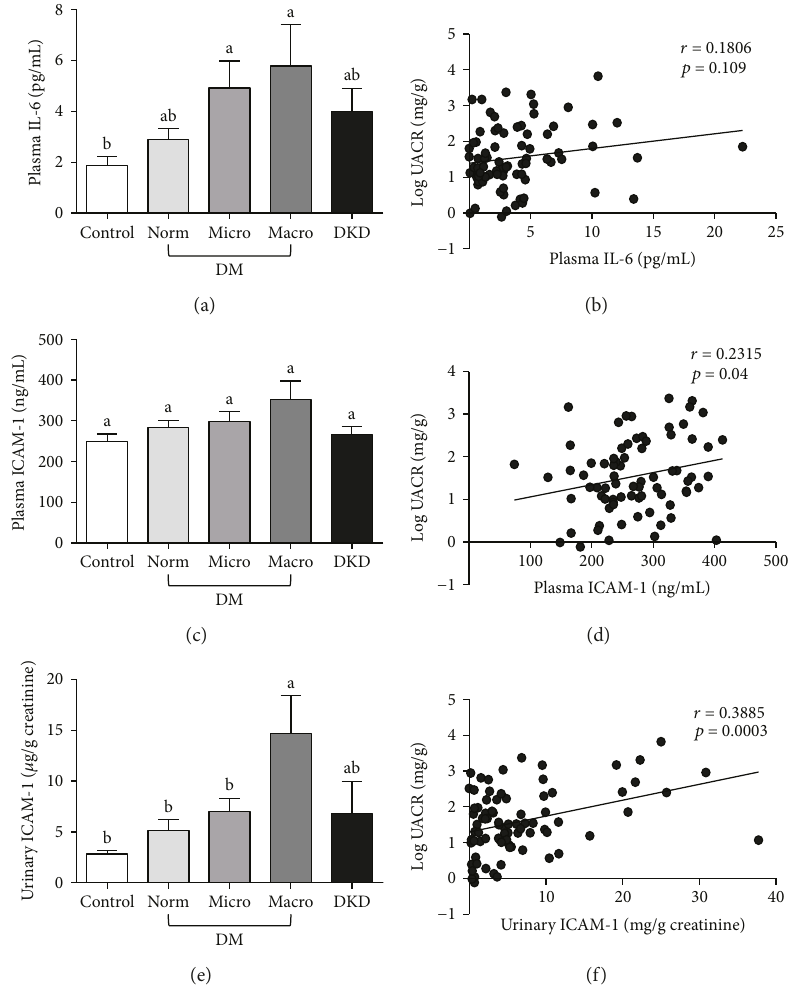
Figure 4: Plasma IL-6 (a), ICAM-1 (c), and urinary ICAM-1 (e) in diabetic African American men, age-matched nondiabetic controls, and diabetic patients with diagnosed DKD. Diabetic patients were classi fi ed into three groups: normo-, micro-, and macroalbuminuria, based on the UACR. The correlation between plasma IL-6 (b), ICAM-1 (d), or urinary ICAM-1 (f) and log-transformed UACR in diabetic and DKD groups. Data are represented as mean ± SEM . Labeled means without a common letter are signi fi cantly di ff erent ( p < 0 05 ). Table 2: Correlation coe ffi cient between in fl ammation markers and clinical characteristics in diabetic African American men.